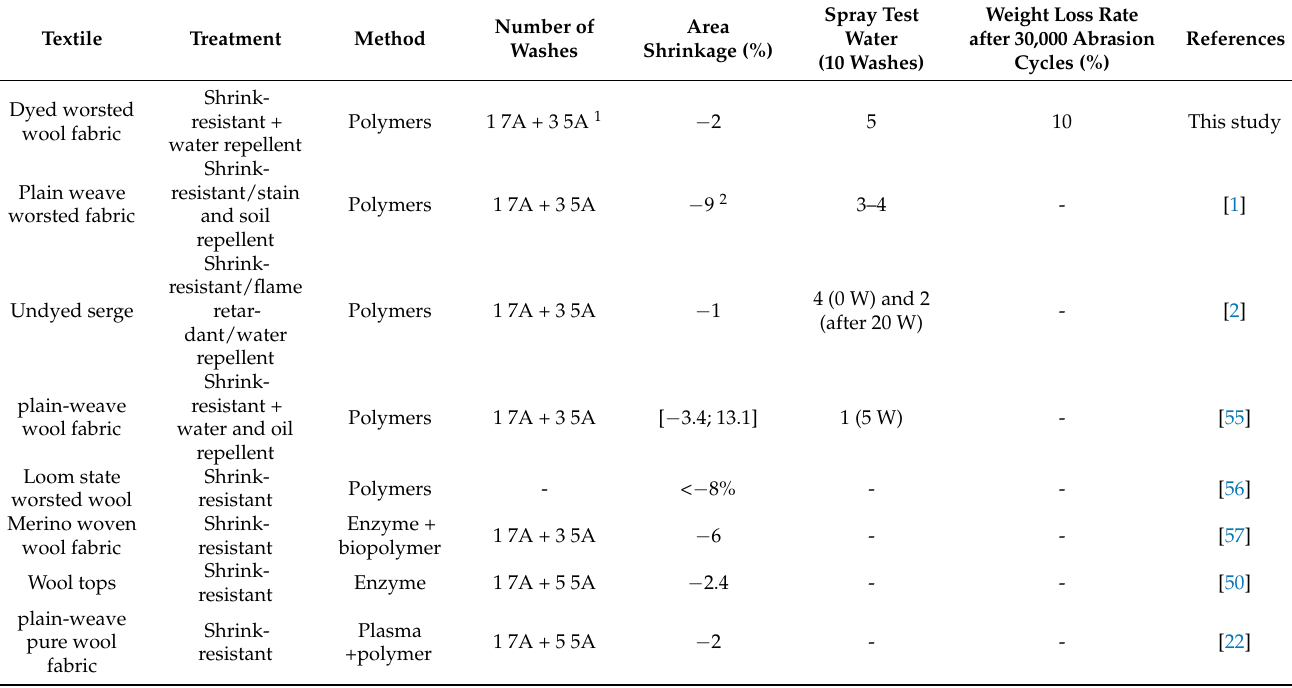
Table 8. Shrink-resistant and water repellency results of previous and recent